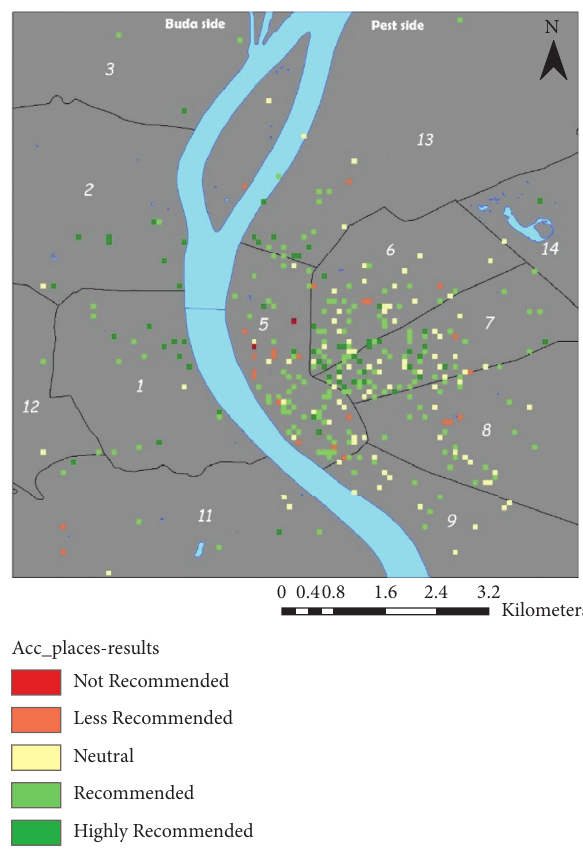
Figure 7: The final map of accommodations in Budapest City.